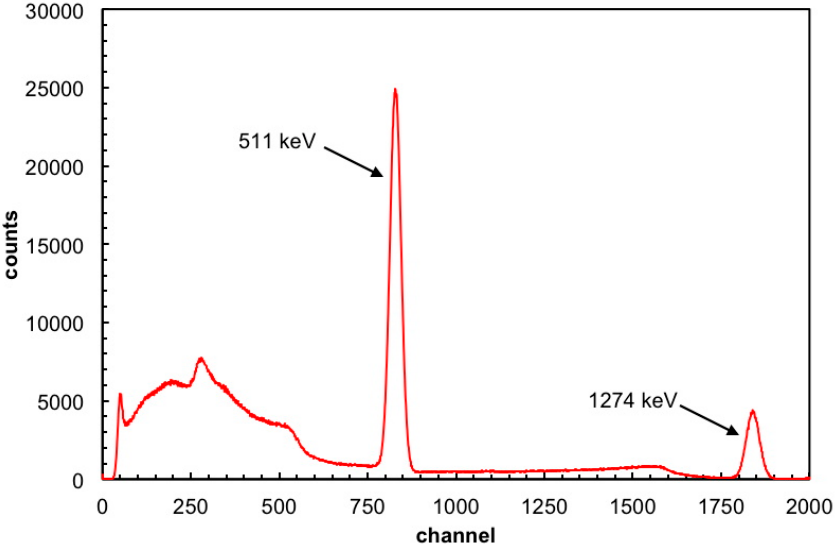
Figure 27. Energy spectrum of a 22 Na radioactive source obtained with a LaBr scintillator of the GDA detector. The peaks at 511 keV ( β + annihilation) and 1274 keV (direct gamma decay) respectively around channel 830 and 1840, are clearly visible, with FWHM resolution of 4% and 2%, respectively.